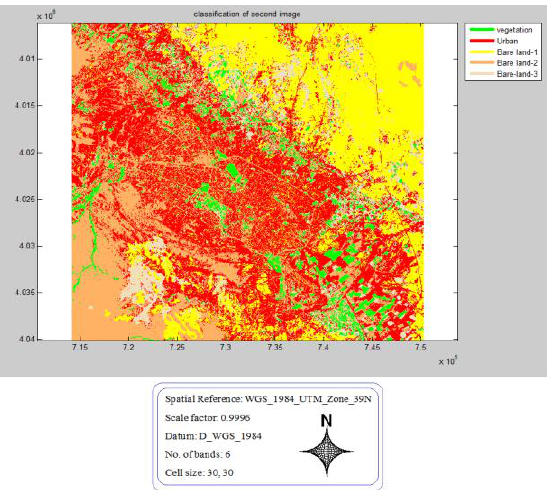
Figure 5. The second classified image related to March 24, 2017